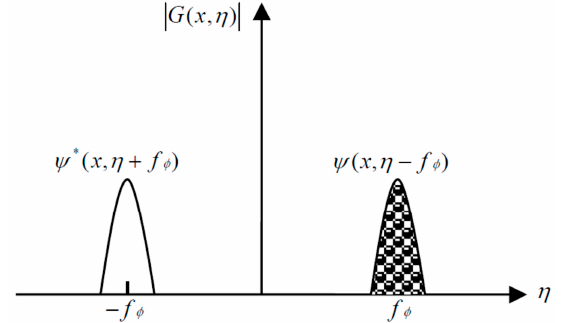
Figure 2. Spectral distribution.